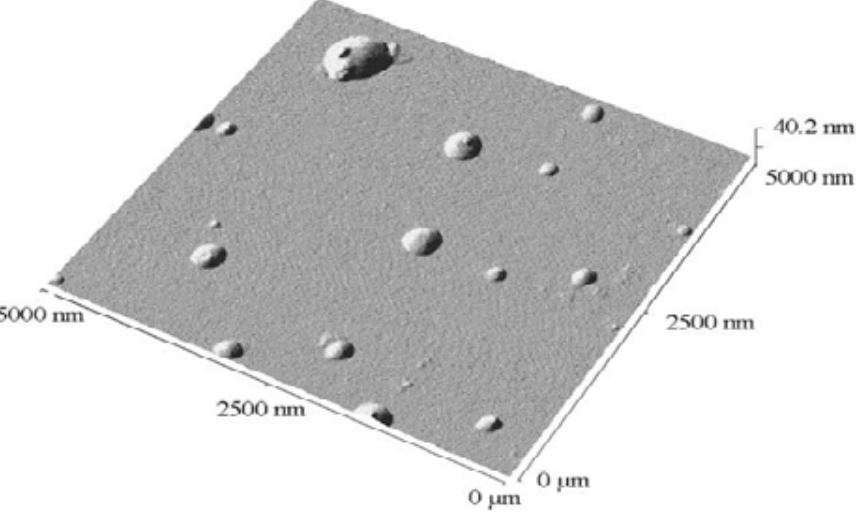
Figure 3. Non-contact mode atomic force microscopy (AFM) images of 2d -based SLNs reconstituted after freeze-drying in a solution of glucose (2%) at 5 mm scan